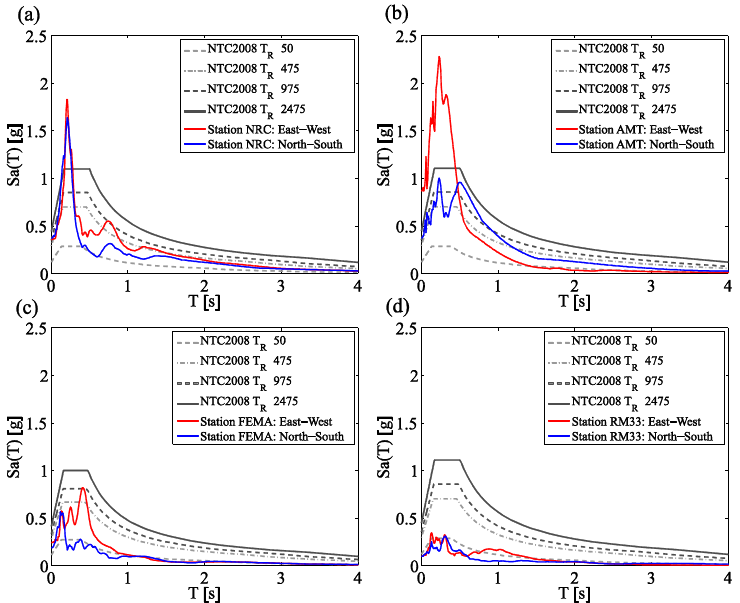
Figure 1. Comparison between the observed ground motions and the elastic design spectra provided by